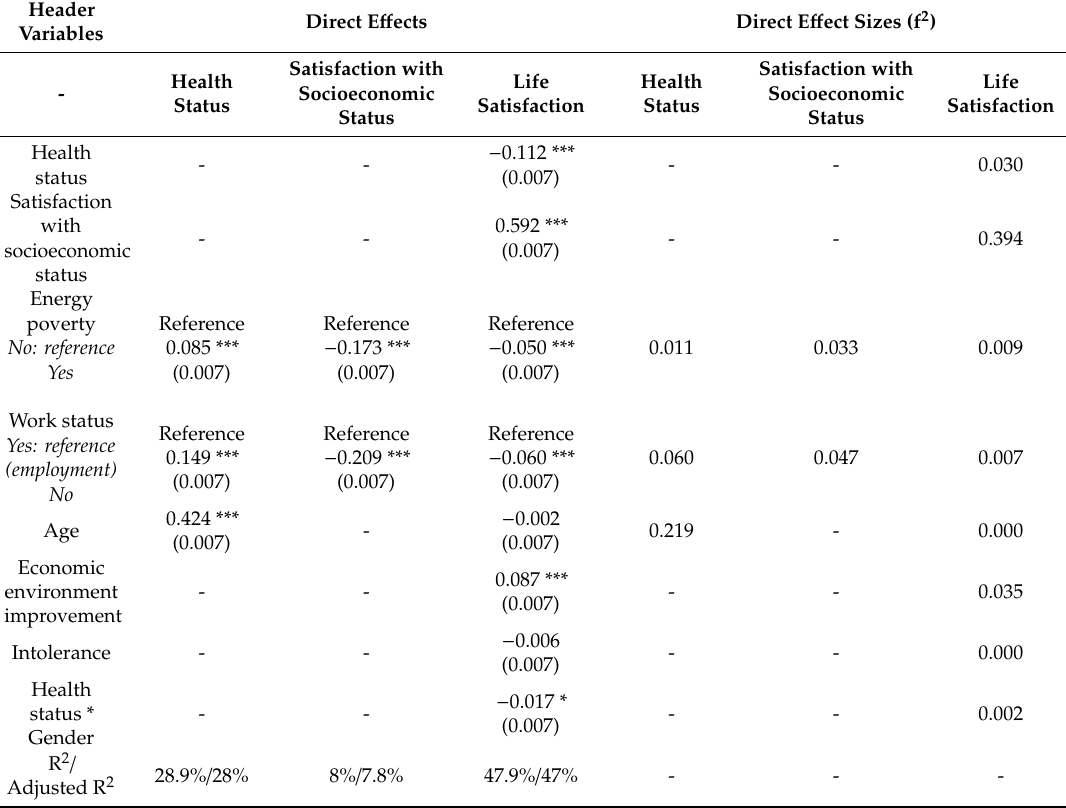
Table 4. Direct e ff ects and direct e ff ect